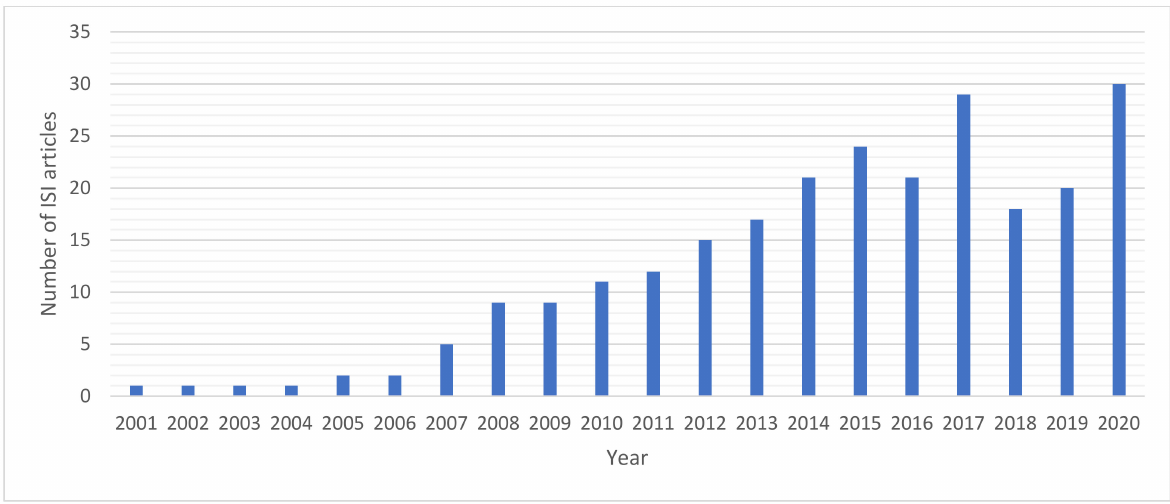
Figure 1. Yearly variations of the number of ISI articles concerning the topic “time-lapse ERT” spanning the period 2001–2020 (Source data: WoS